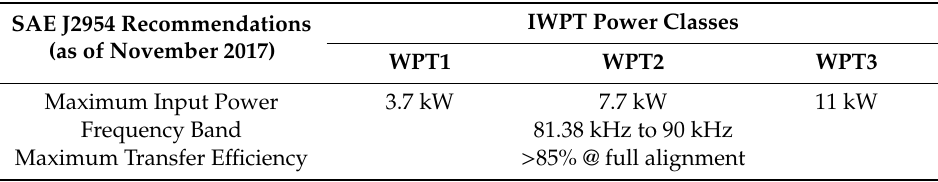
Table 1. SAE J2954 recommended power levels, e ffi ciency and frequency band.